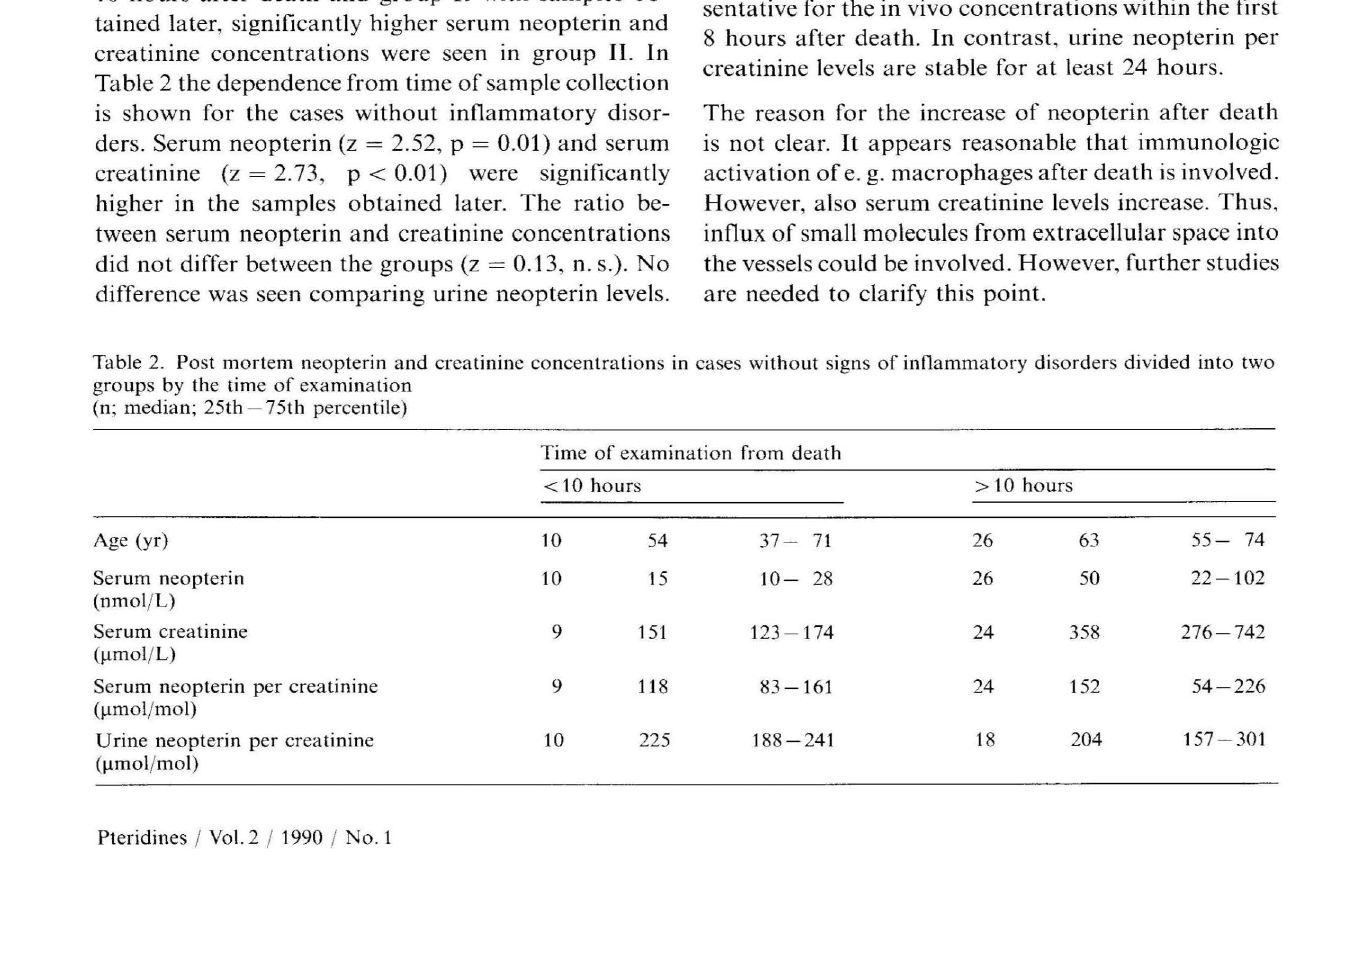
tween serum neopterin and creatinine concentrations